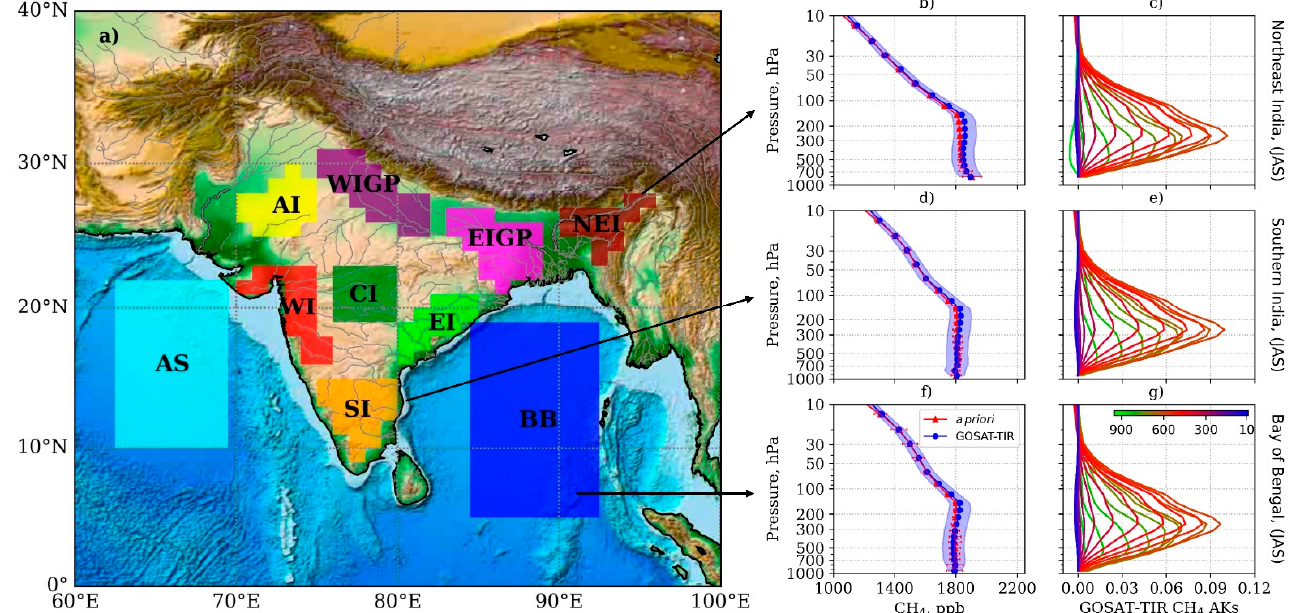
Figure 1. The map of the regional divisions for the analysis ( a ), depicted by unicolor boxes with the name abbreviations defined in Section 2.1. The black lines in-land show major rivers in the plot domain; the human settlements along the rivers are major sources of CH 4 . The TIR CH 4 a priori with 1- σ SD uncertainty (red line with error bars) and TIR CH 4 profile with the retrieval error (blue line with shaded area) are shown in panels ( b , d , f ), and the 22 AK functions corresponding to the 22 retrieval layers are in panels ( c , e , g ). Data in panels ( b – g ) are shown for the regions Northeast India, Southern India, and the Bay of Bengal, averaged over the period July–September 2011.